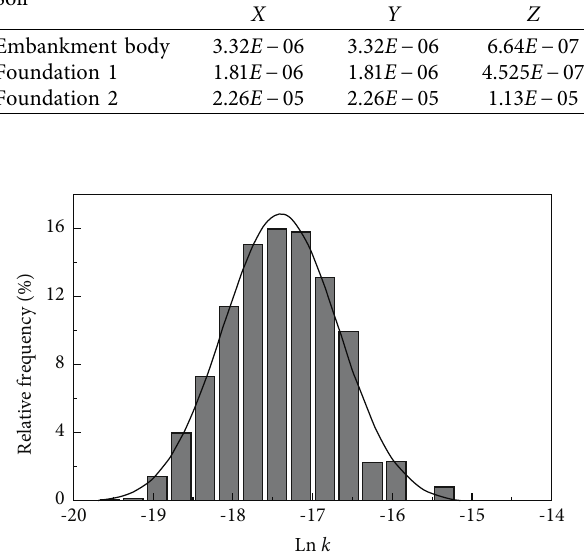
Figure 2: Probability density distribution of the hydraulic con- ductivity in the embankment body.